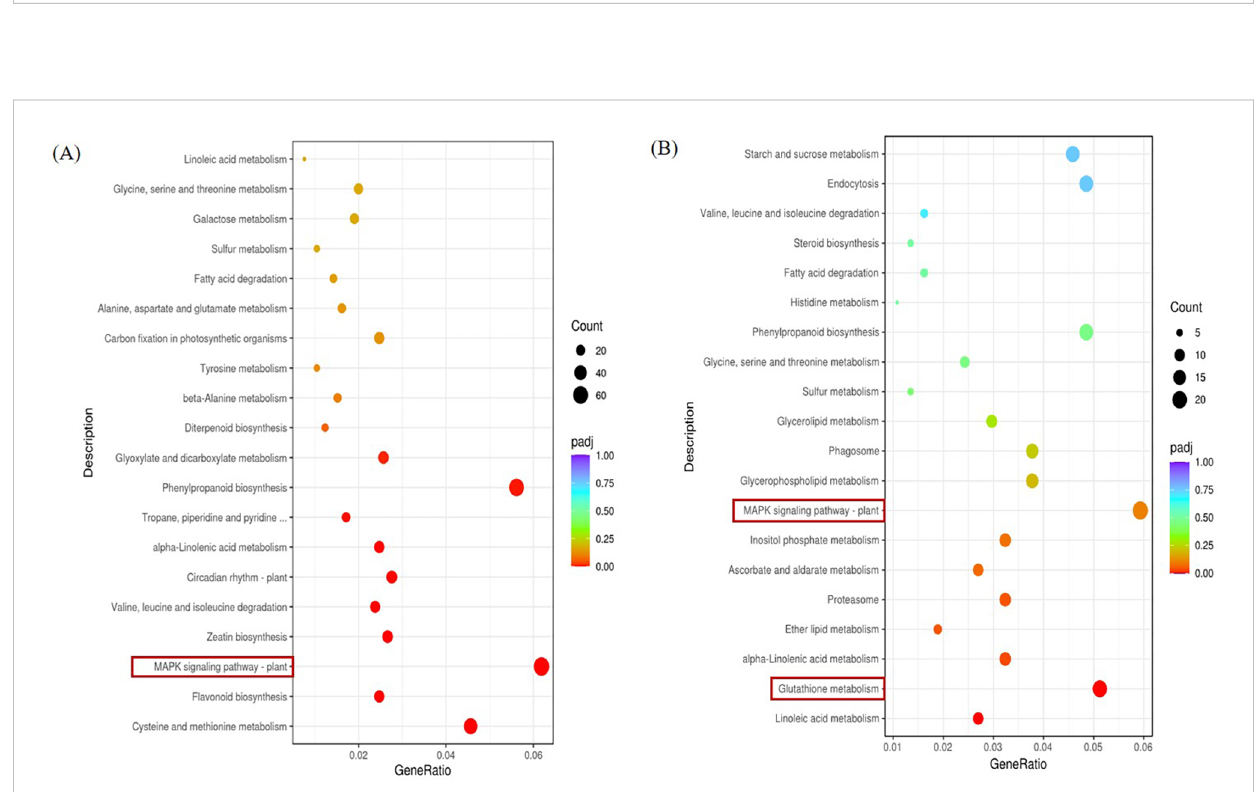
FIGURE 7 KEGG pathway of DEGs KEGG. (A) KEGG pathway signi fi cantly enriched by DEGs in the root parts compared with salt stress treatment in CK, P < 0.05. (B) KEGG pathway signi fi cantly enriched by DEGs in leaf parts compared with salt stress treatment in CK, P <